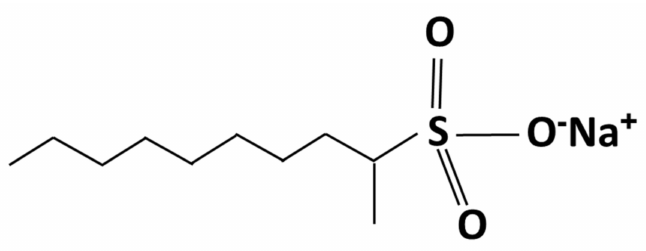
Figure 1. Chemical structure of alfa olefin sulfonate.